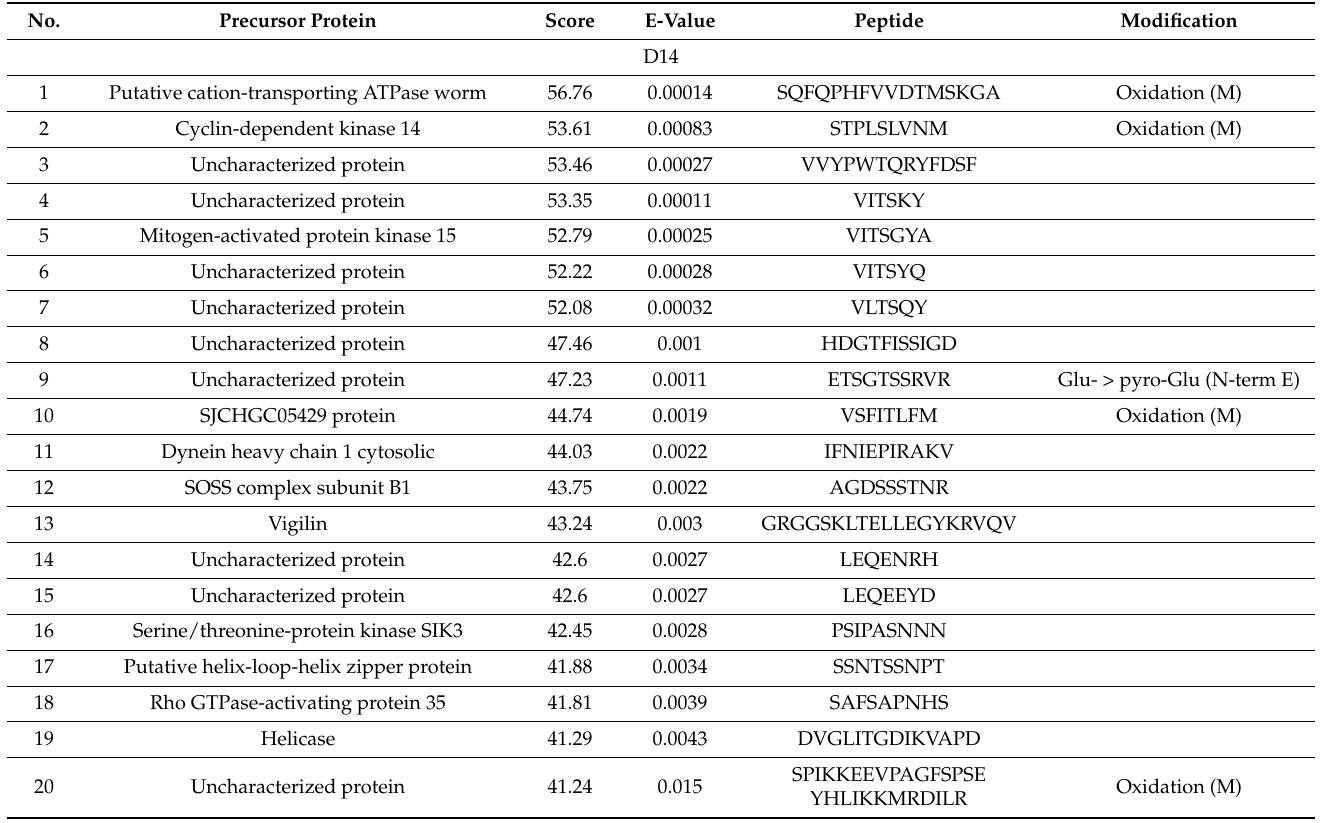
Figure 5. Venn diagram of S. mekongi peptides in mouse sera collected pre- and post-infection (days 14, 28 and 56) identified by mass spectrometry. Table 2. Top 20 S. mekongi peptides identified from infected mouse serum at 14, 28 and 56 days after infection ranked by peptide scores.